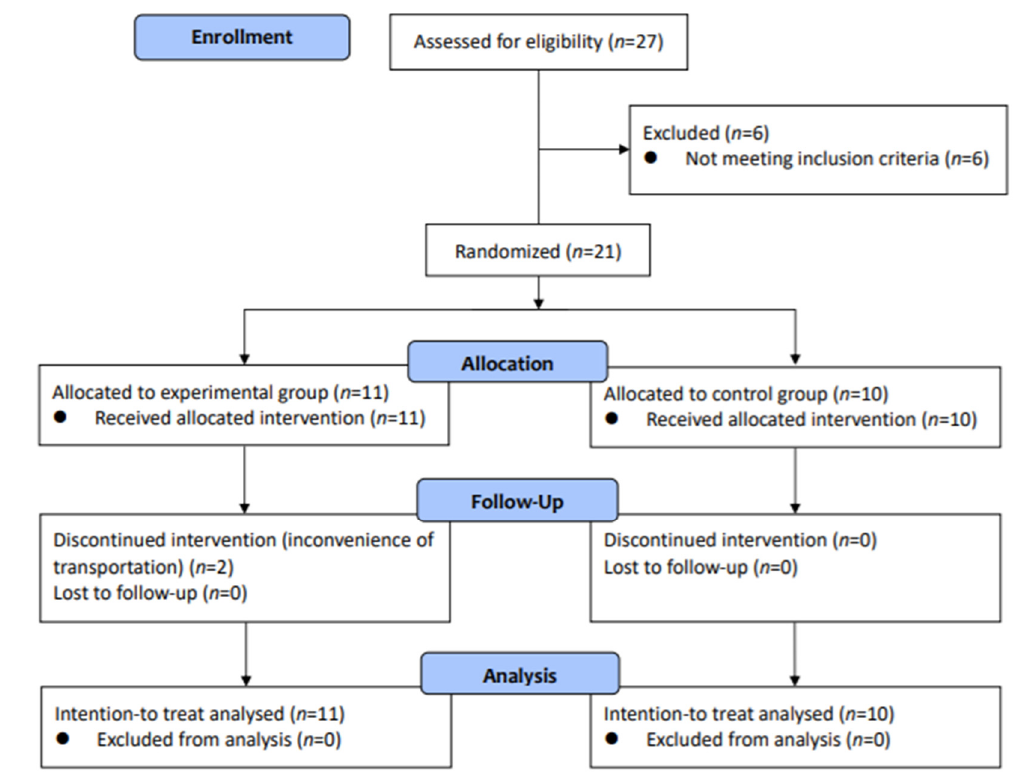
Figure 1. Flowchart of the experimental design.